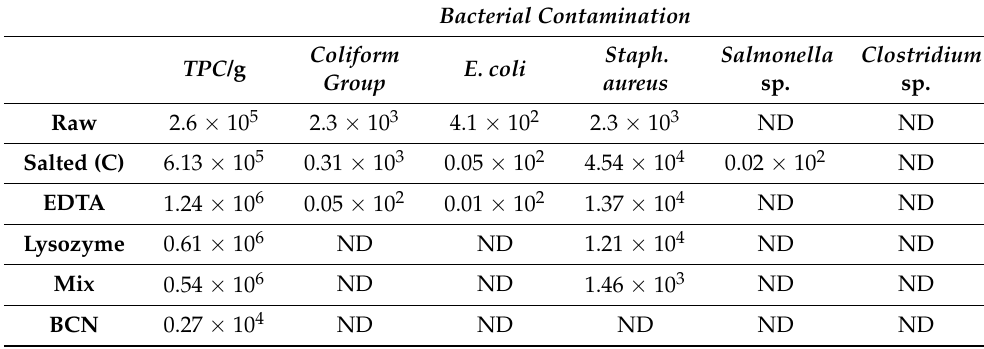
Table 3. Microbial flora determined for investigated mullet samples after maturation.